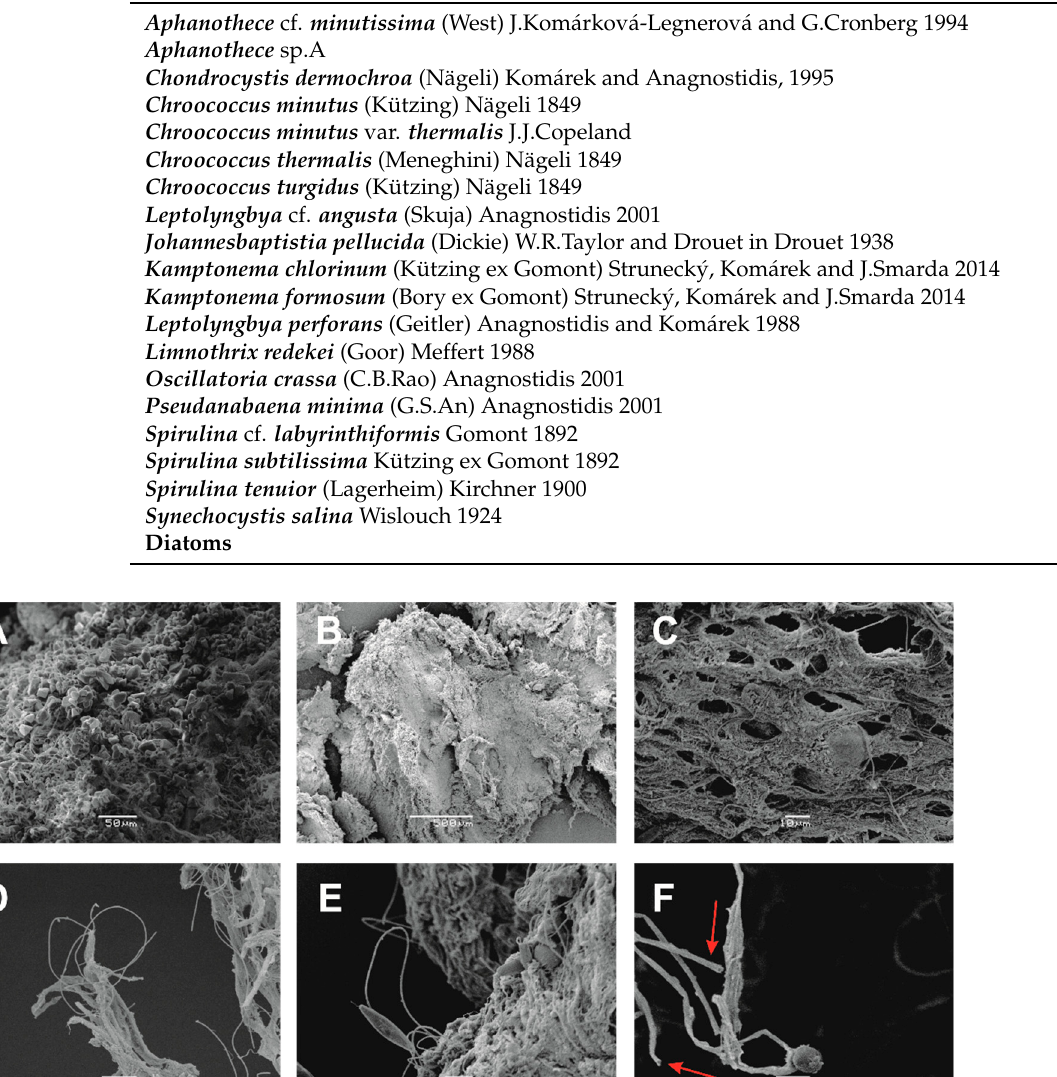
Table 2. Identified Cyanobacteria species.